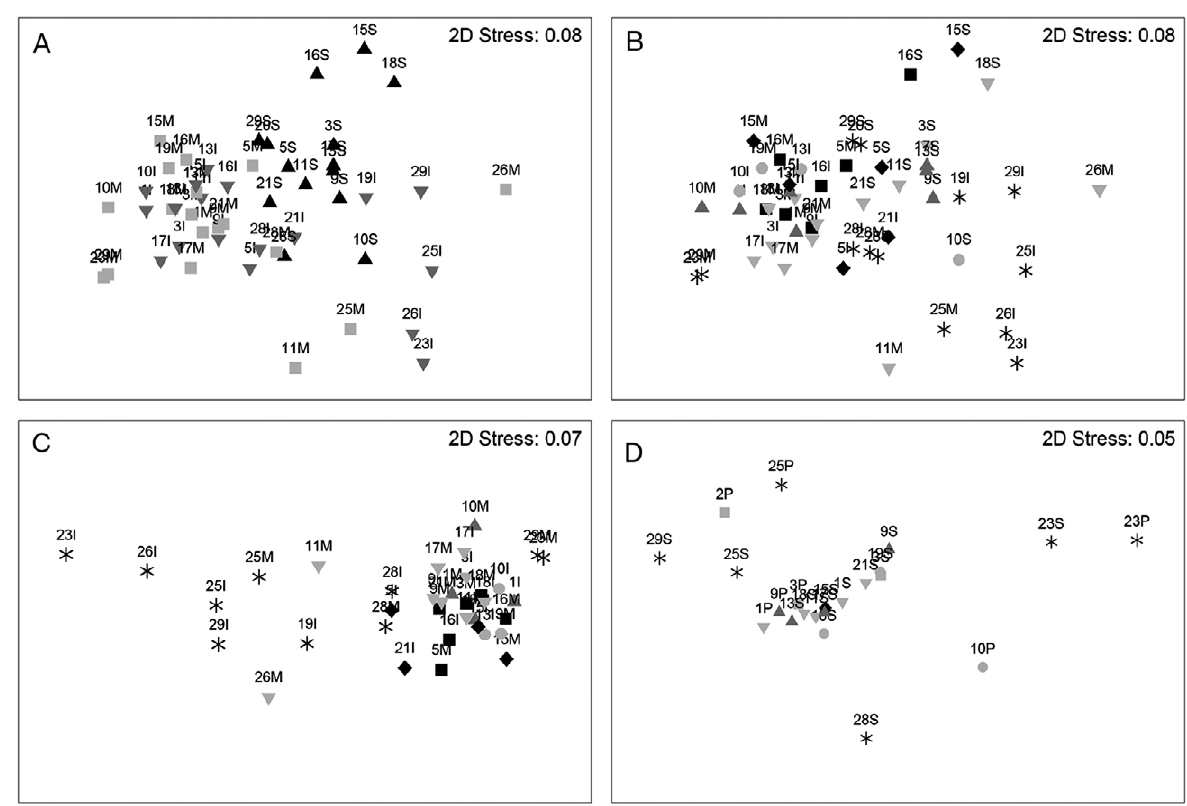
Fig. 3. – MDS plots. A, plot based on macrofauna abundance (ind m –2 ) of grab samples showing the littoral level: S, supralittoral, dark triangle; M, mediolittoral, quadrat; I, infralittoral, bright triangle. B, plot based on macrofauna abundance (ind m –2 ) of grab samples showing the sedi- ment type. C, plot based on macrofauna abundance (ind m –2 ) of the medio- and infralittoral grab samples showing the sediment type. D, plot based on macrofauna collected with traps in the supralittoral, with label indicating the sampling method (P, pitfall; S, sticky). Labels indicate the site number and the littoral level in plots A, B and C. Sediment types (see Table 3 for codes) are plotted as follows: C, rhombus; CG, bright triangle; G, dark triangle; CoSG, quadrat; MeS, circle; FiS, asterisk; PO,